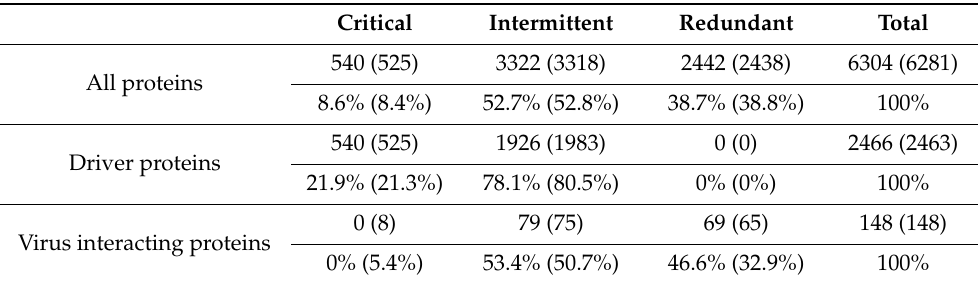
Table 4. The number of proteins of each global controllability classification for all proteins, driver proteins, and SARS-CoV-2 interacting proteins. Values are reported as totals and percent total for the VIN (HIN).